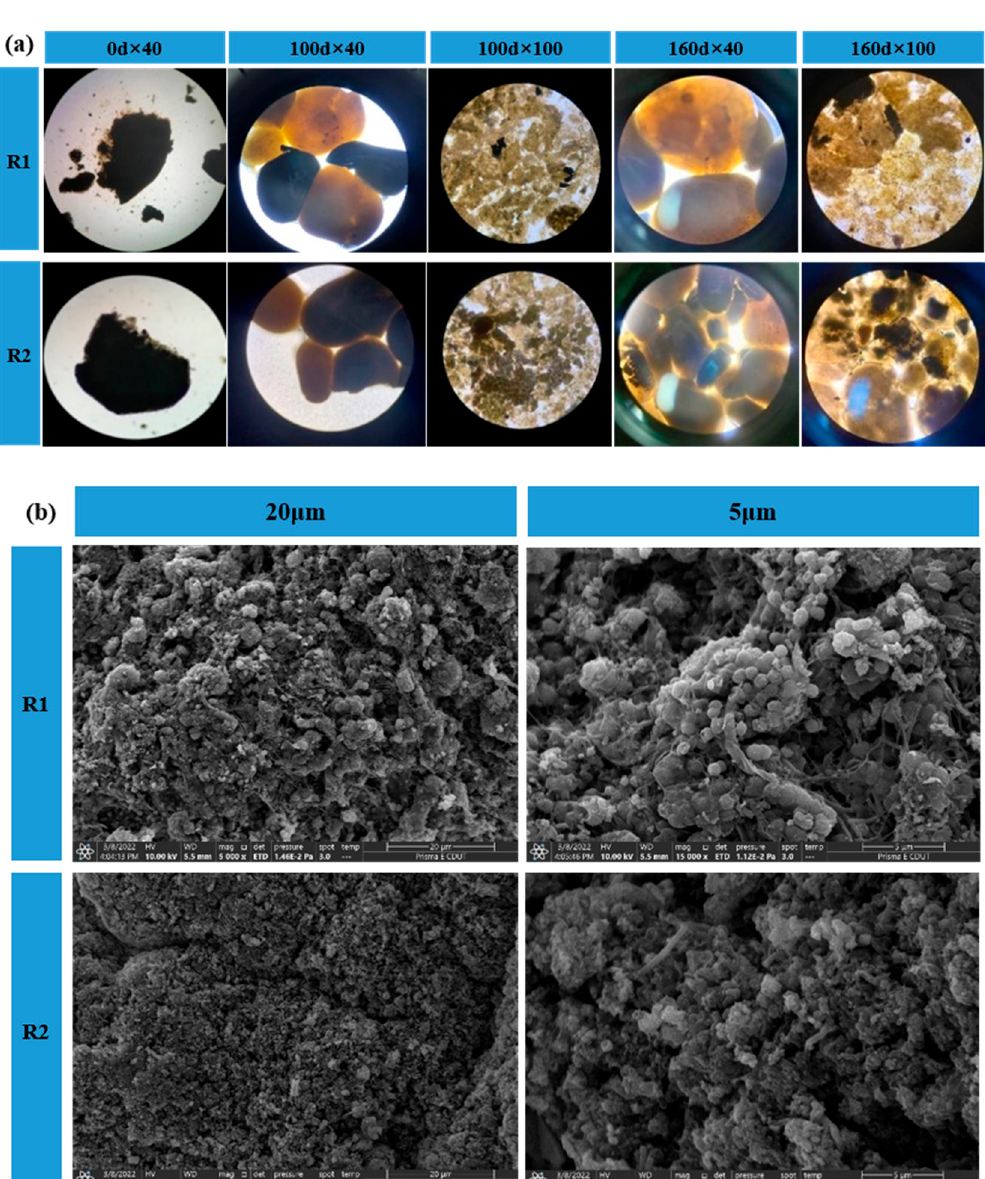
Figure 4. Microbial morphology analysis by ( a ) microscopic microscopy and ( b ) SEM. Pictures represent granular taken on day 0, day 100 and day 160, and floating granules taken on day 160.